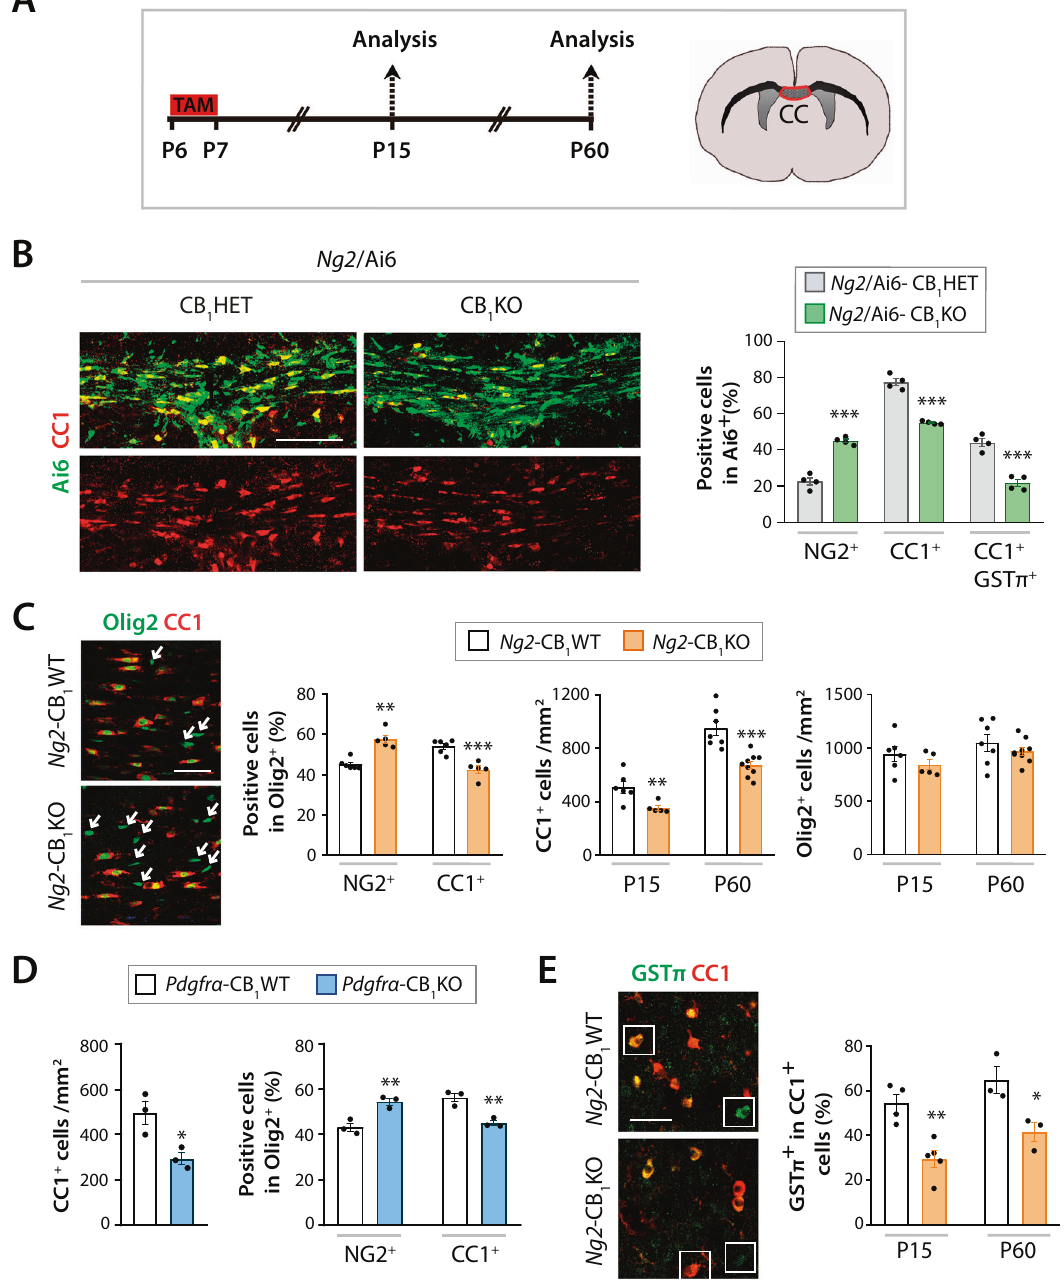
Fig. 1 CB 1 receptor gene inactivation in OPCs disrupts postnatal oligodendrogenesis. A Timeline of tamoxifen administrations and time points of analysis. Tamoxifen-driven recombination was induced at postnatal day 6 (P6-P7) in B Ng2 /Ai6-CB 1 KO, C , E Ng2 -CB 1 KO, D Pdgfr α - CB 1 KO and control mice, and oligodendrogenesis was analyzed in the corpus callosum at P15 and P60. Immuno fl uorescence analysis and quanti fi cation of B the percentage of NG2 + OPCs, CC1 + OLs and GST π + CC1 + mature OLs among the recombinant Rosa-Ai6 + population at P15, ( C , left panel, D ) the percentage of NG2 + OPCs, CC1 + OLs among Olig2 + cells at P15, ( C, D ) Olig2 + and CC1 + OL cell densities at P15 C , D and P60 C , and E the percentage of mature GST π + OLs among CC1 + OLs at P15 and P60. Arrows in B indicate Olig2 + CC1 neg cells. Data are shown as mean + / − SEM. n = 4 for B , n = 5 – 9 for C , n = 3 for D , n = 3 – 5 for E independent data points used per experimental group. * p ≤ 0.05, ** p ≤ 0.01, *** p ≤ 0.001 vs Ng2 /Ai6-CB 1 HET, Ng2 -CB 1 WT or Pdgfr α -CB 1 WT mice, by two-tailed unpaired Student ’ s t-test for B , D , E , and by two- tailed unpaired Student ’ s t-test or Mann Whitney test for C . Scale bars, 80 µm for B , and 30 µm for C and E ’ . recognition (NOR, Fig. 3E) and y-maze (Fig. 3F) tests. Altogether, reduced motor activity and coordination in the open fi eld these observations show that CB 1 receptor de fi ciency in OPCs at (Fig. 3A), beam walking (Fig. 3B), and Actitrack (Fig. 3C) tests compared to Ng2 -CB 1 WT mice. Ng2 -CB 1 KO also showed an early postnatal ages causes hypomyelination at young adult ages, which is translated into impaired motor and memory anxiety-like behavior in the open fi eld and elevated plus-maze functions, and anxiety-like behaviors. (EPM) (Fig. 3A, D) tests, and memory de fi cits in the novel object Cell Death and Disease (2022)